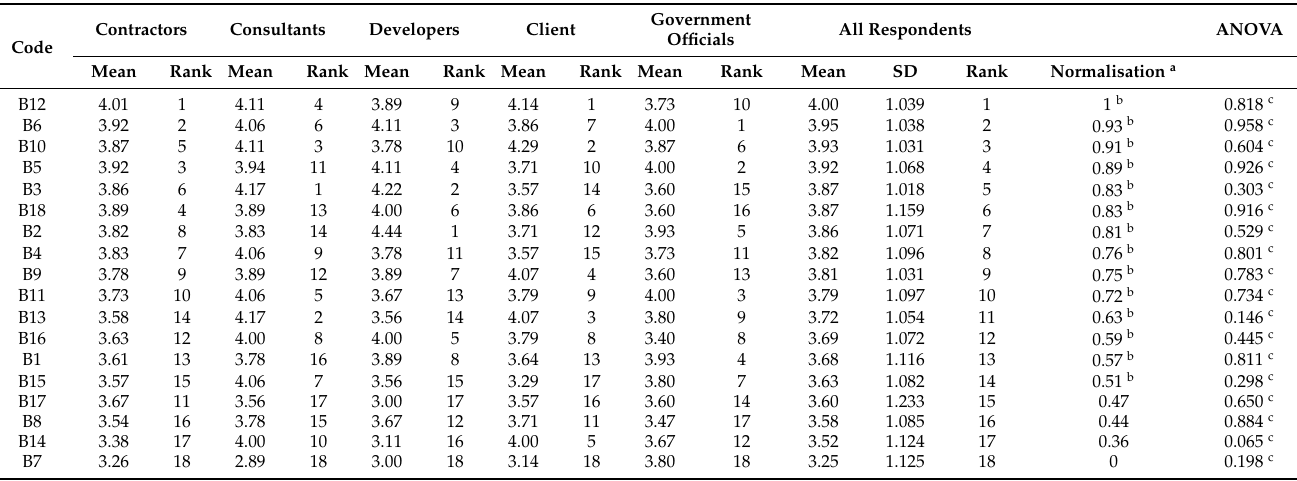
Table 2. Barriers to the social acceptance of sandbag technology uptake in housing construction; intergroup